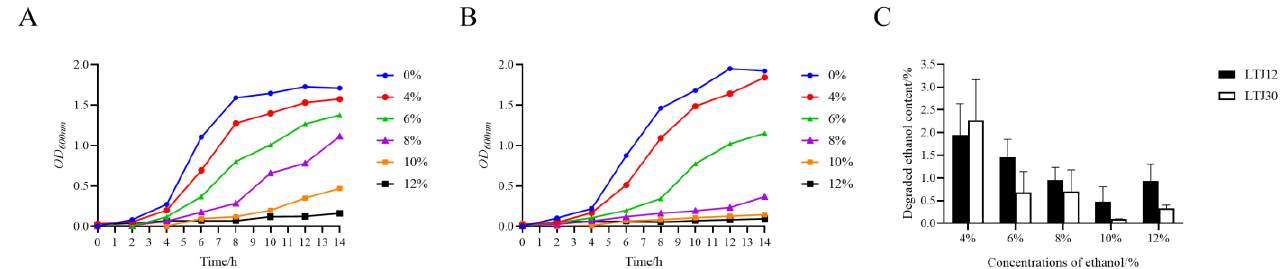
Figure 1. Effects of ethanol stress on strains. ( A ) Growth curve of LTJ12 during treatments of ethanol at different concentrations. ( B ) Growth curve of LTJ30 during treatments of ethanol at different concentrations. ( C ) Ethanol degradation ability of strains at different ethanol concentrations for 12 h. The values represent the means of the three replicates with the standard deviation